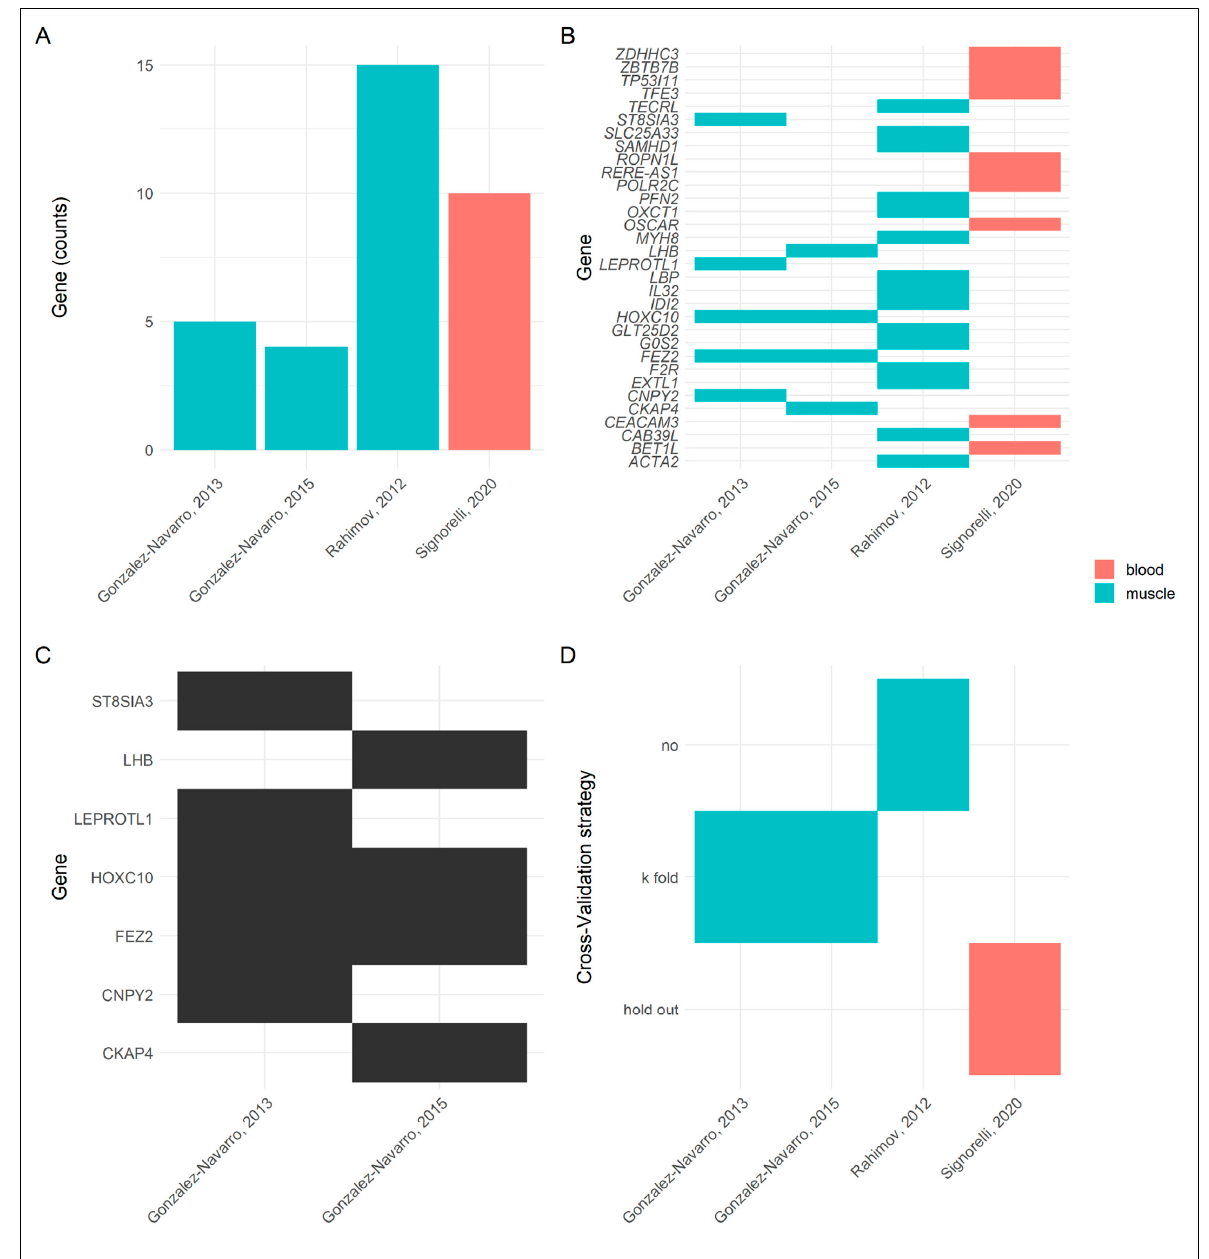
Figure 2. A comparison of gene-expression-based AI models with data attained from (Gonza-lez-Navarro et al., 2013 [117], Gonza-lez-Navarro et al., 2015 [118], Rahimov 2012 [81] and Signorelli 2020 [103]). ( A ) Bar plot indicating the number of DEGs found in the considered studies. Up to 15 DEGs representing potential biomarkers for FSHD were identified across 4 studies. ( B ) Tile plot indicating which genes were found by the considered studies. All of the genes identified in blood (red) were not retrieved in the other studies based on muscle biopsies (blue), and this may be due to the different levels of gene expression of the two biological samples. However, only two genes of 15 were identified both from Gonzalez-Navarro et al., 2013 and Gonzalez-Navarro et al., 2015 across the experiments performed on muscle data. ( C ) Tile plot with a focus on the studies by Gonzalez-Navarro et al. The studies proposed by these authors were performed on the same dataset and used the same SVM algorithm. Despite these favorable conditions, only 2 out of 7 DEGs were confirmed. ( D ) Tile plot to visualize the cross-validation strategies used in FSHD vs. HD modeling, suggesting that the performance metrics used may be inflated by the low sample size (12 < n <